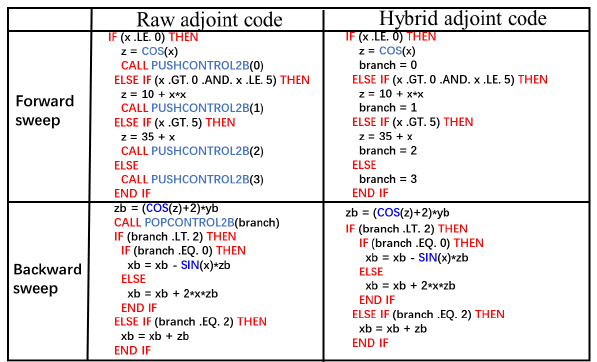
Figure 3. Case 1: the raw adjoint code and the hybrid adjoint code.